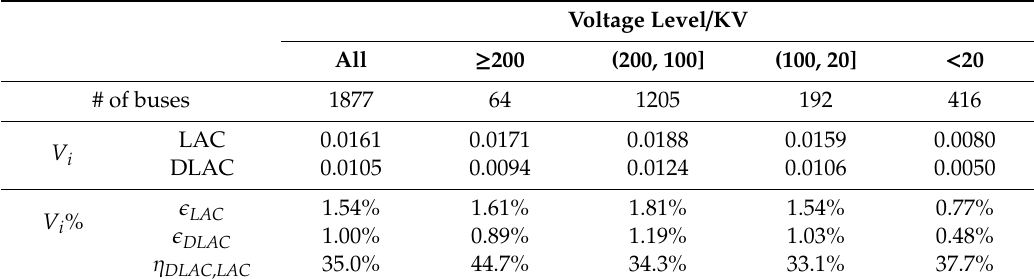
Table 9. Results of Voltage with the DLAC and LAC Models for Hour 1 Case.